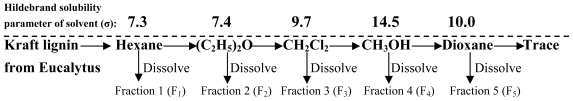
Scheme for the separation process of lignin from black liquor of Eucalyptus pellita Kraft-AQ pulping.